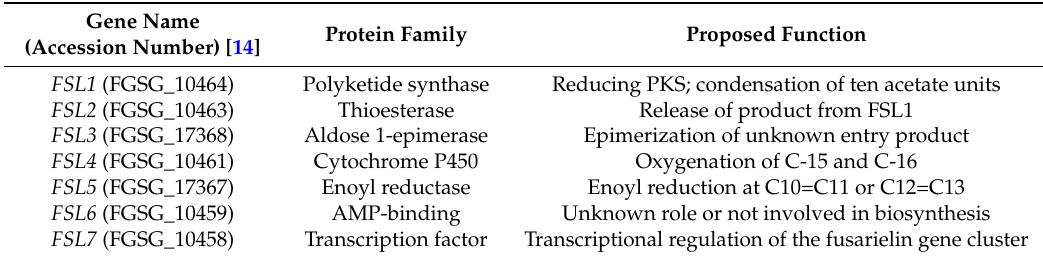
Table 1. Genes in the fusarielin ( FSL ) gene cluster and their proposed